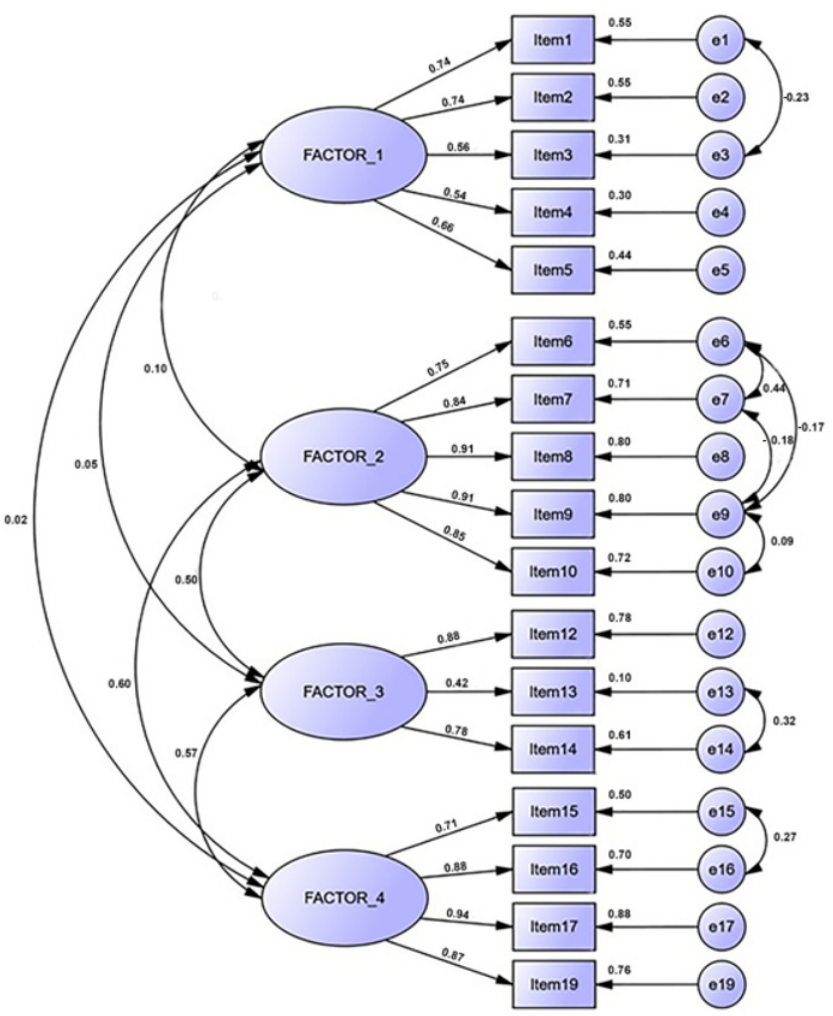
Figure 1. CEFI-R questionnaire factor model.